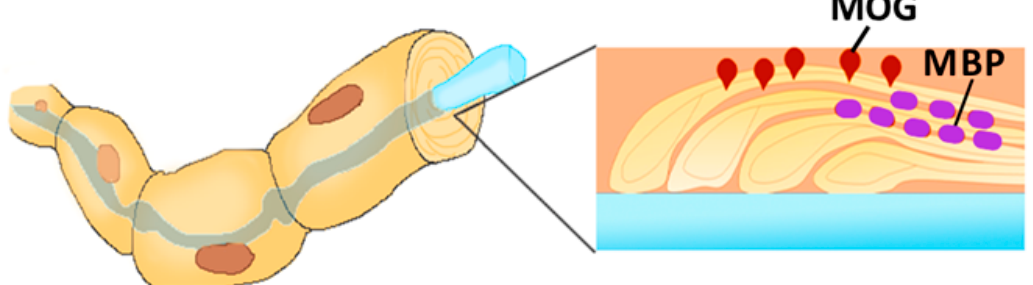
Figure 2. Myelin-associated glycoprotein (MOG) expression on the surface of the myelin, covering the axon. The myelin sheets are held together with Myelin basic protein (MBP), while MOG is located on the surface and exposed to the autoreactive leukocytes.